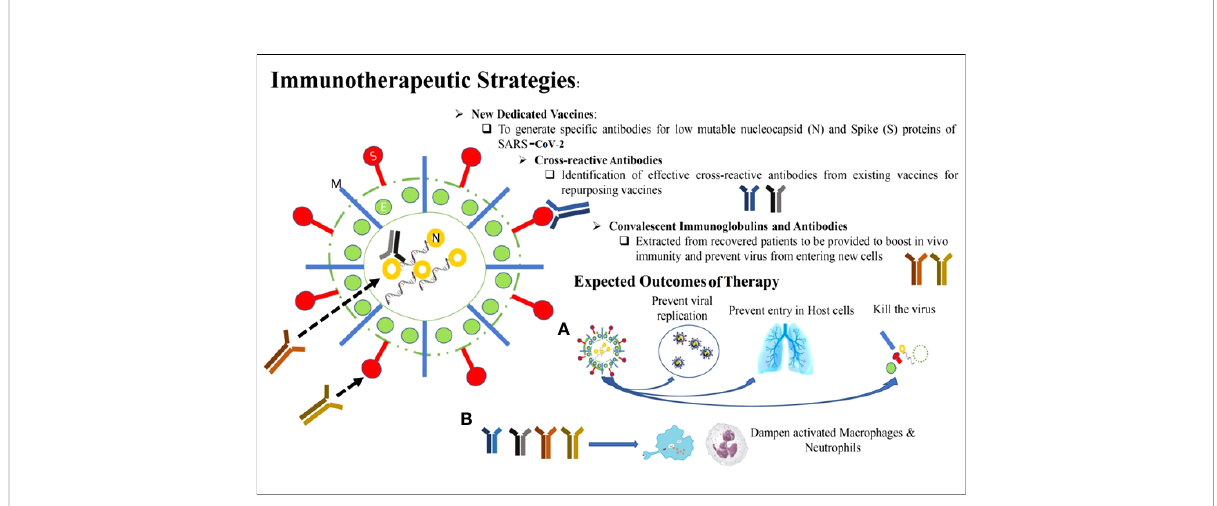
FIGURE 5 Immunotherapeutic strategies for the management and treatment of